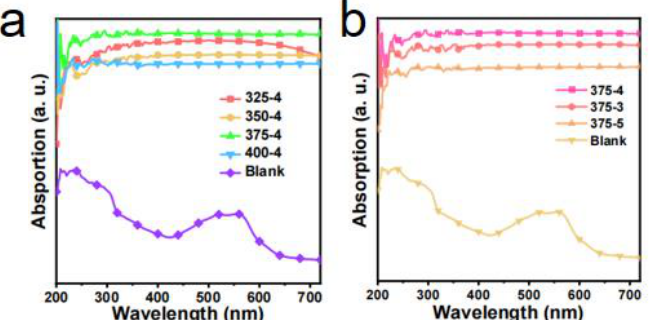
Figure 3. UV-Vis absorption spectra of the carbonized coconut fiber membranes: ( a ) different carbonized temperatures for 4 min and ( b ) different carbonized times at 375 °C.